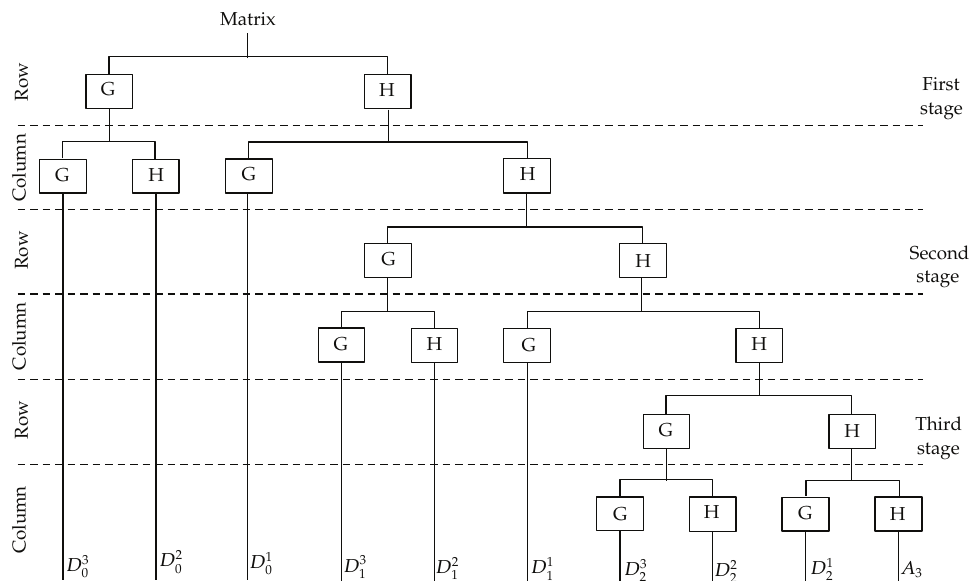
Figure 1: The two-dimensional DWT: one-dimensional transform in the rows and columns of the matrix.